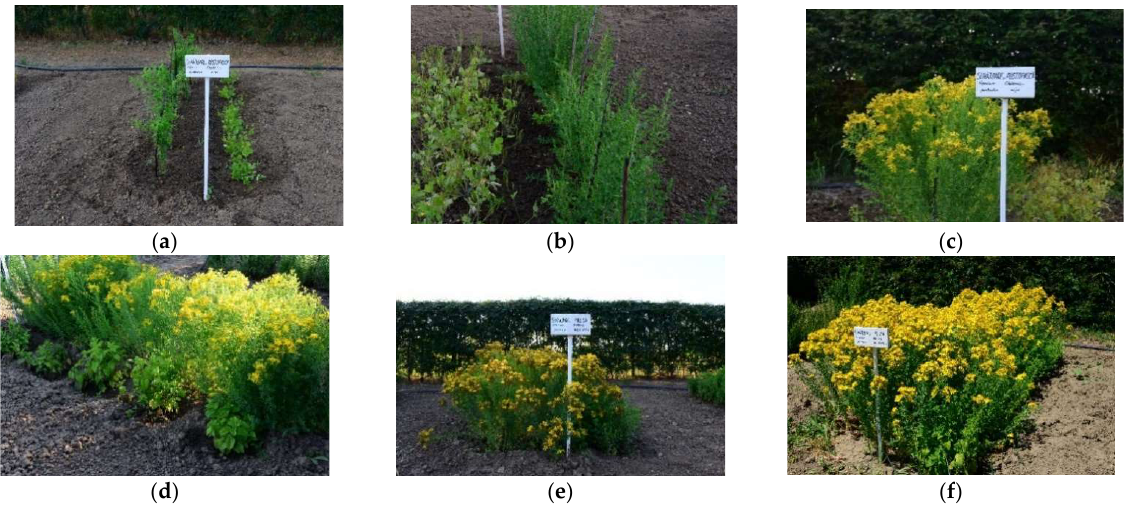
mon crop– Melissa officinalis L(Figure 7d–f).